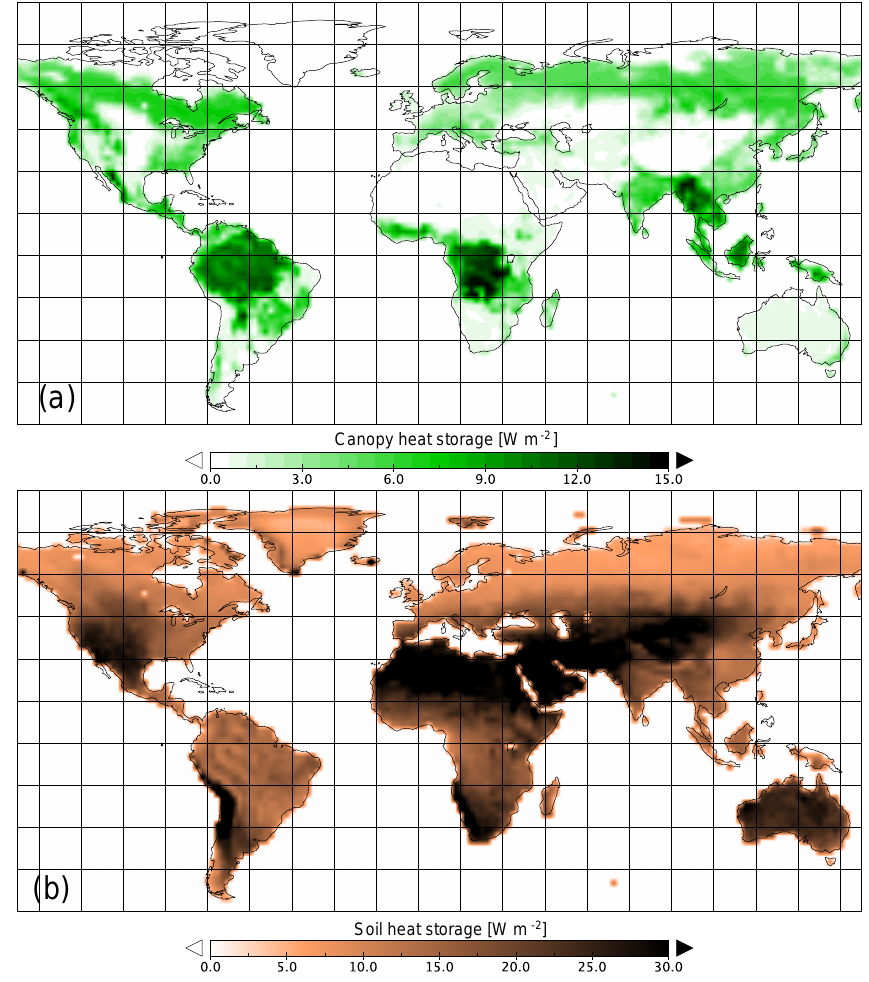
Figure 4. Comparison of canopy and soil heat storage: global distribution of the positive contributions of the canopy heat storage ( S cano ) (a) and the soil heat storage ( S soil ) (b) , both in Wm − 2 as a 30-year mean